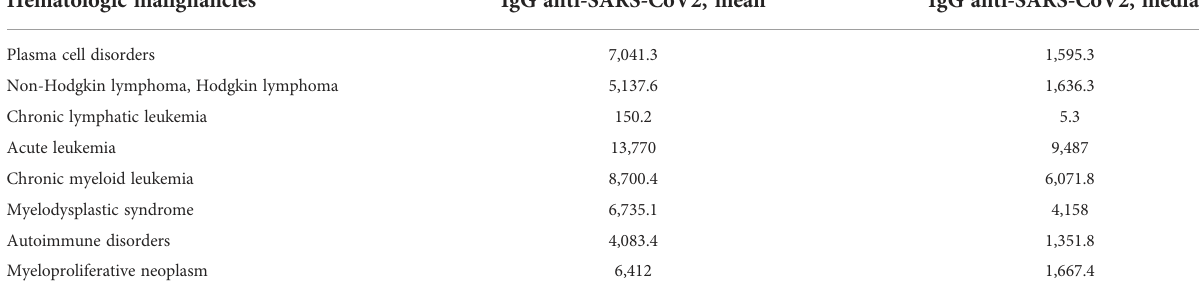
TABLE 3 Concentrations of IgG anti-SARS-CoV2 in hematologic malignancies (AU/mL). Hematologic malignancies